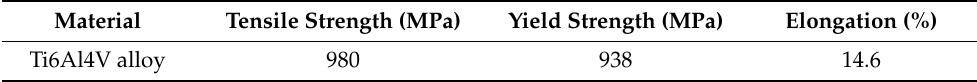
Table 2. Mechanical properties of the Ti-6Al-4V